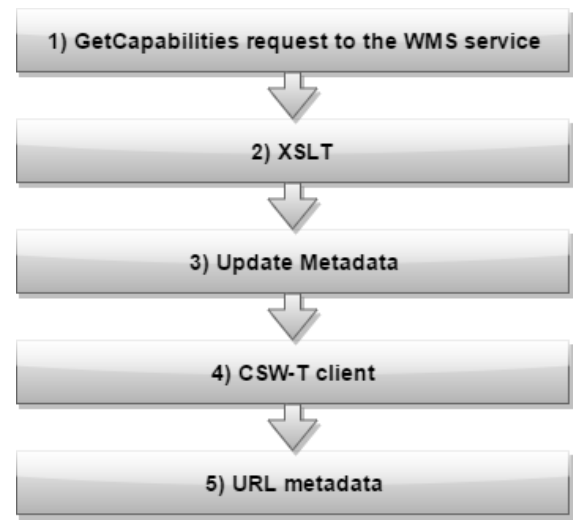
Figure 9. Steps metadata generator. XSLT: eXtensible Stylesheet Language Transformations.